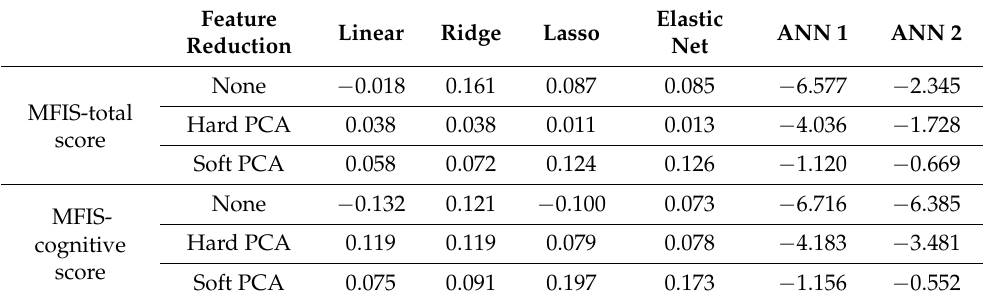
Figure 4. 𝑅 (cid:2870) scores for each Modified Fatigue Impact Scale–cognitive regression model (linear, ridge, lasso, elastic net, ANN 1, and ANN 2) for each feature reduction type (no principal compo ‐ nent analysis [PCA], hard PCA, soft PCA). The negative section of the vertical axis is not represented